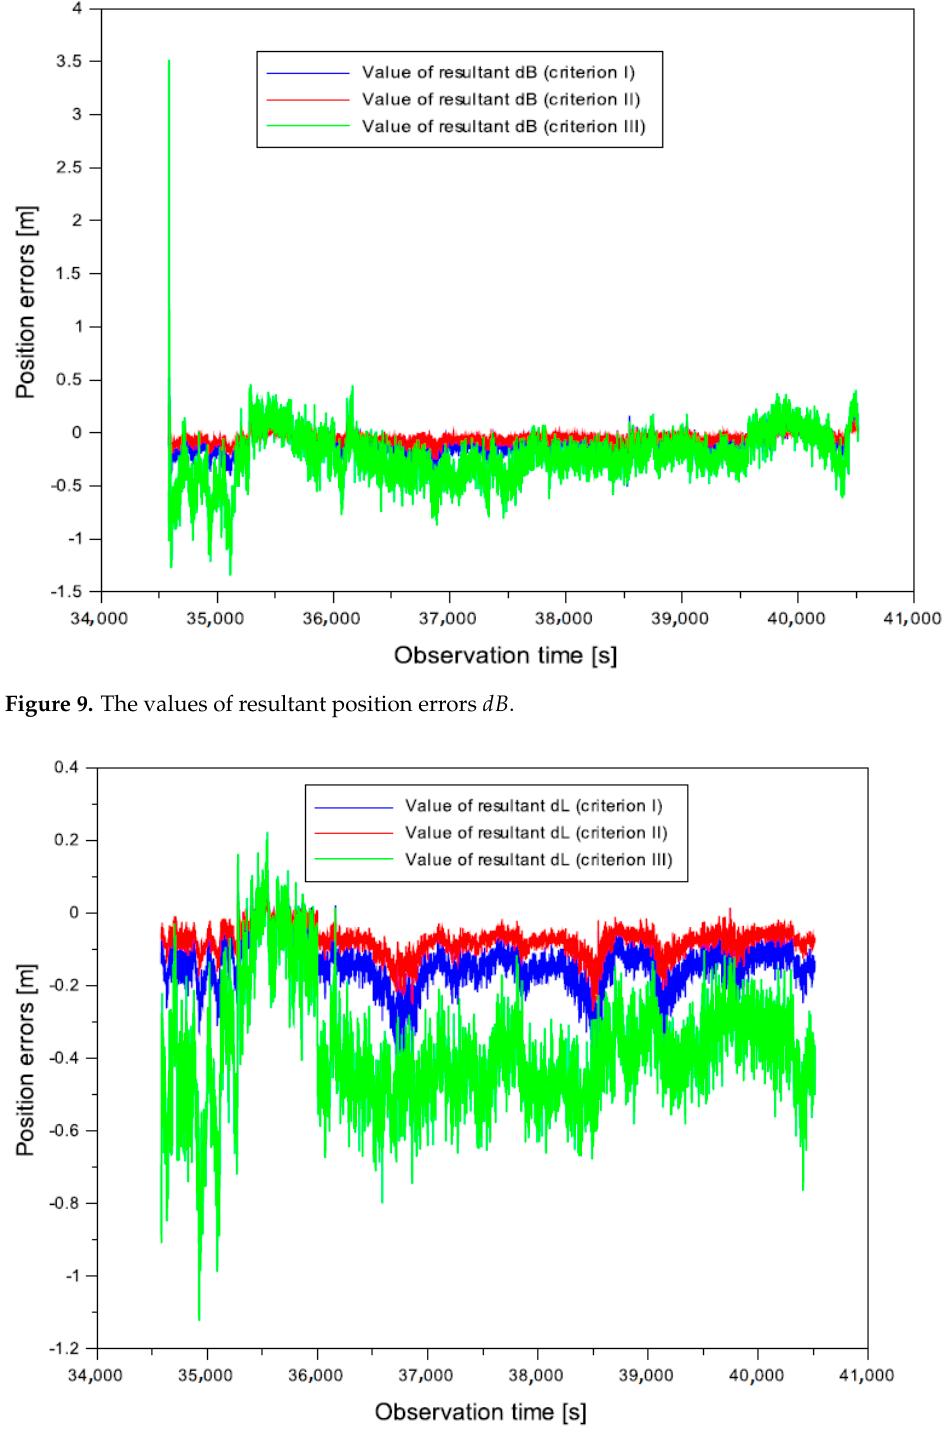
Figure 10. The values of resultant position errors dL .